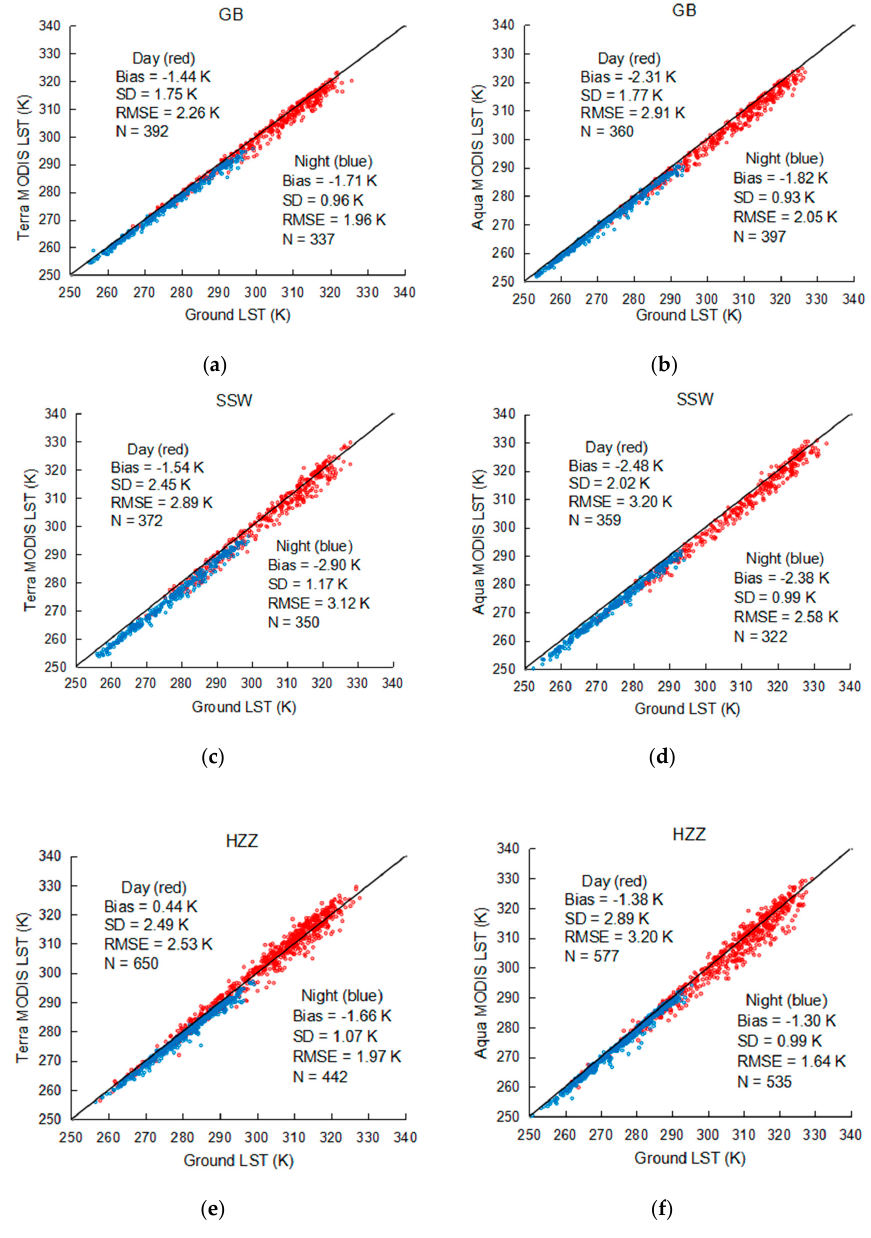
Figure 2. Scatterplots between Moderate Resolution Imaging Spectroradiometer (MODIS) collection-6 (C6) LSTs and ground measurements for daytime and nighttime at the three sites, i.e., Terra MODIS LSTs versus ground measurements at ( a ) GB site, ( c ) SSW site, and ( e ) HZZ site; Aqua MODIS LSTs versus ground measurements at ( b ) GB site, ( d ) SSW site, and ( f ) HZZ site.